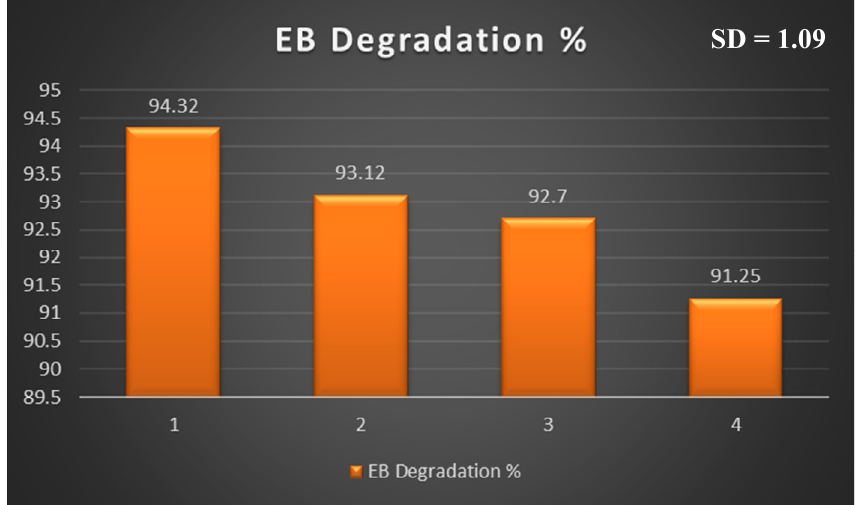
Fig. 10. Effect of reusability and photostability test of ZO3 nanoparticle on photocatalytic degradation of